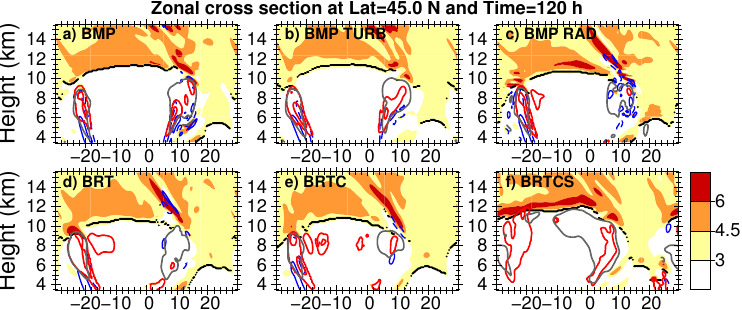
Figure 11. Zonal cross sections along 45 ◦ N of static stability N 2 (in 10 − 4 s − 2 ) after 120h of model integration. Red lines show specific cloud-ice content q i (for 5 . 0 × 10 − 6 kgkg − 1 ), solid blue lines show regions with positive values of ∂w/∂z (for 10 . 0 × 10 − 5 s − 1 ), dashed blue lines show negative values (for − 10 . 0 × 10 − 5 s − 1 ), and solid gray lines show regions with (cid:49)z tracer larger than 2 . 5km. The thick black line is the thermal tropopause. The six panels show (a) BMP, (b) BMP RAD, (c) BMP TURB, (d) BRT, (e) BRTC, and (f)